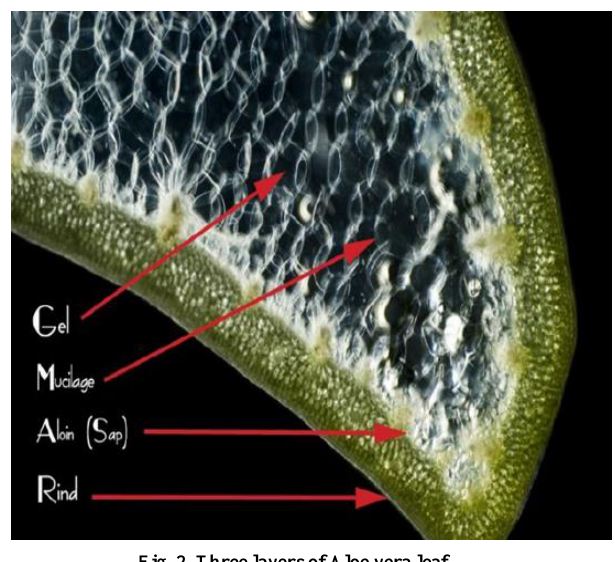
Fig. 2. Three layers of Aloe vera leaf.